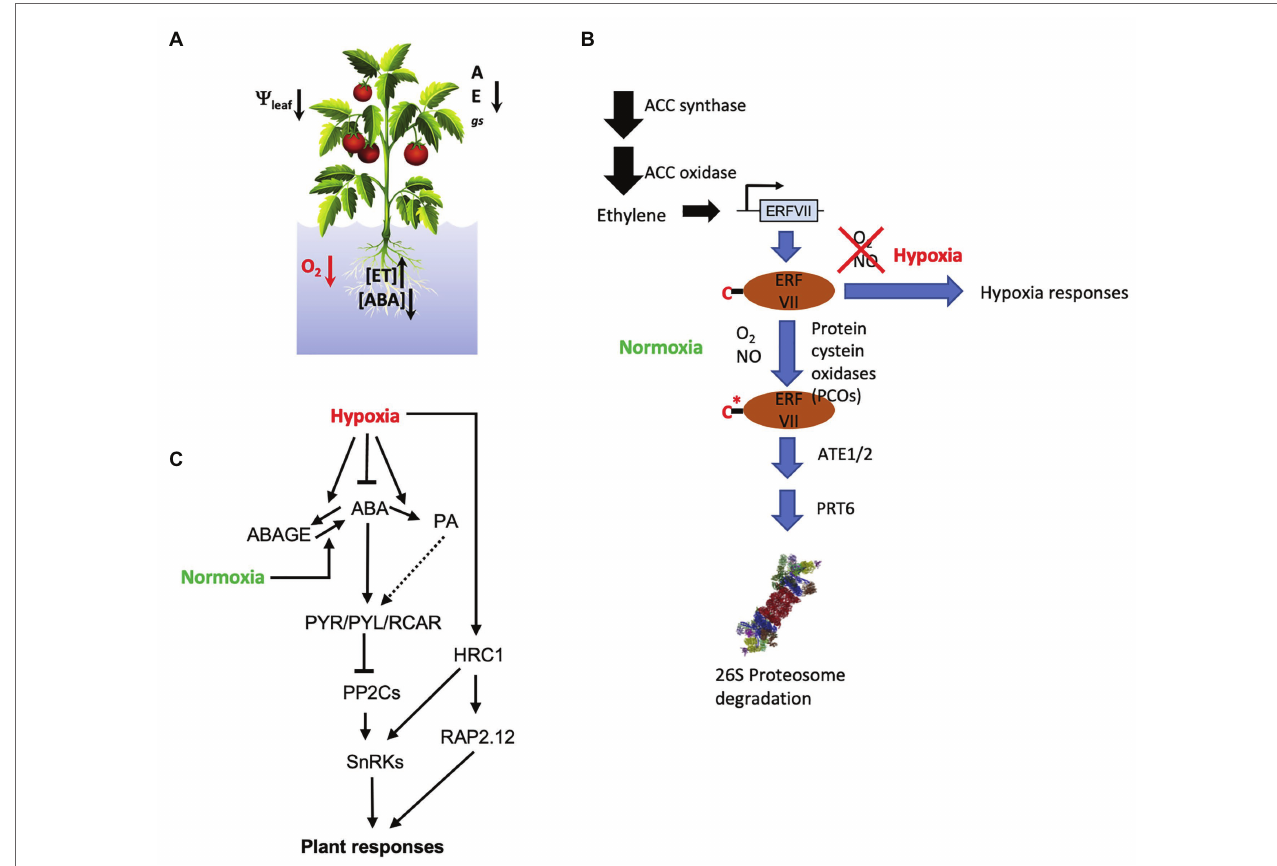
FIGURE 1 | Plant responses to oxygen deprivation: (A) Physiological and hormonal responses to soil flooding where gs is stomatal conductance, E is transpiration rate, and A is the photosynthesis rate; (B) ethylene and N-degron pathway coordinate the tissue response to both normoxia and hypoxia O 2 conditions, C * indicates the modification of Cys to Cys-sulfinic acid in the presence of O 2 ; and (C) molecular players involved in the interaction of the core abscisic acid (ABA) signaling with O 2 conditions at molecular level in higher